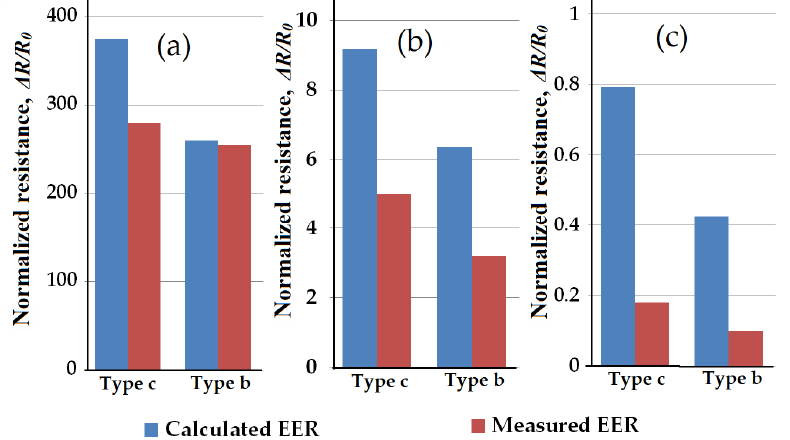
Figure 12. The relative effective electric resistance for samples type b and c experimentally measured and calculated: ( a ) samples containing 50 phr CB, ( b ) 60 phr CB and ( c ) 70 phr CB.